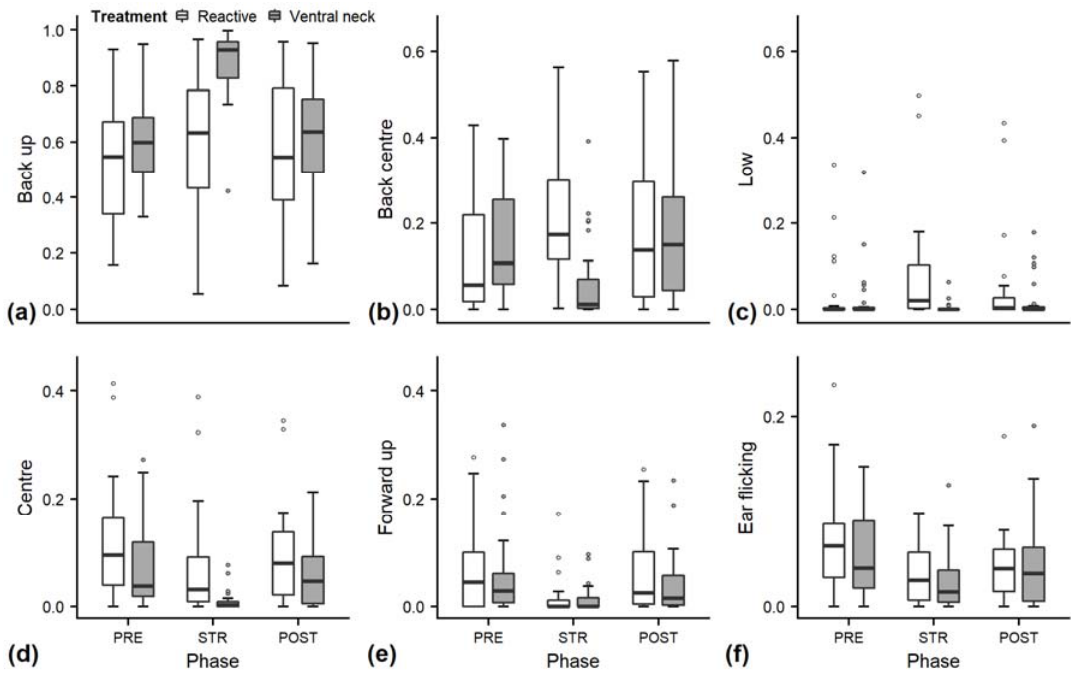
Figure 3. Durations of ear positions of heifers ( n = 28) (as a proportion of the total time observed) during the experimental trials. Means were calculated across the three trials per treatment and are depicted according to the treatment used (white = “reactive”, dark grey = “ventral neck”) and phase (PRE = pre-stroking, STR = stroking, POST = post-stroking). Statistics for GLMMs: significant e ff ect of treatment × phase for back up ( a ), back centre ( b ) and ear low ( c ), p < 0.001; significant main e ff ect of phase: centre ( d ) and forward up ( e ), p < 0.05. Ear flicking ( f ) was not evaluated statistically. Note that the y-axis scale varies to allow for su ffi cient resolution for rare ear positions.